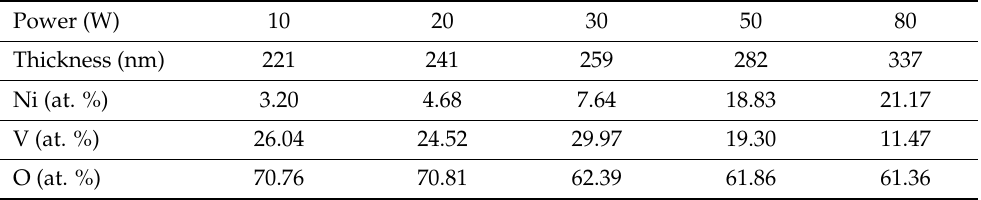
Table 1. The composition of the Ni-V-O mixed oxide film with respect to various sputtering powers toward the Ni target.